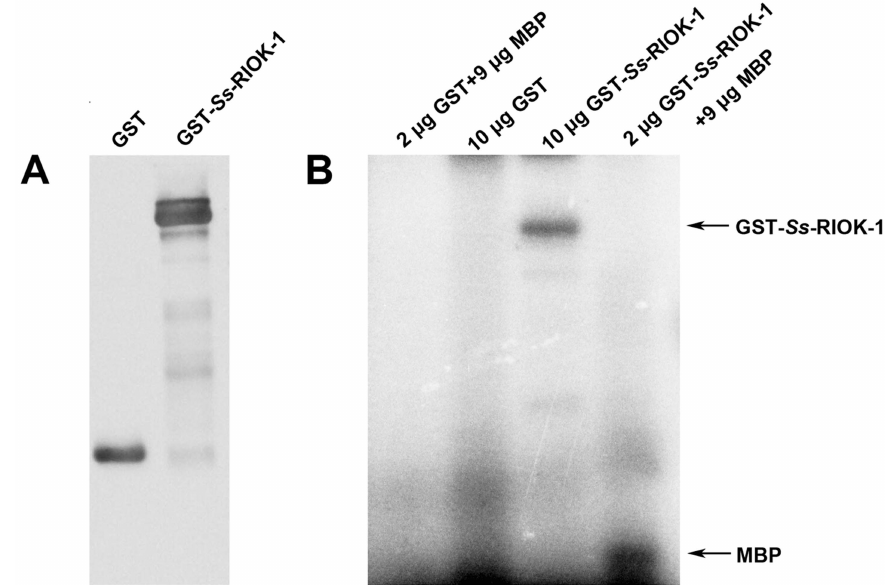
Figure 5. Autophosphorylation and phosphorylation activity of recombinant GST- Ss -RIOK-1. A, Western-blot of GST- Ss -RIOK-1 (89 kDa) and GST (28 kDa) are immunoprecipitated with GST antibody. B, Kinase assay showing autophosphorylation and phosphorylation activities of recombinant GST- Ss -RIOK-1 (89 kDa). Substrate in phosphorylation assay is MBP (18 kDa). Amounts of each protein in the reaction are indicated in the labels. Purified GST constitutes the negative